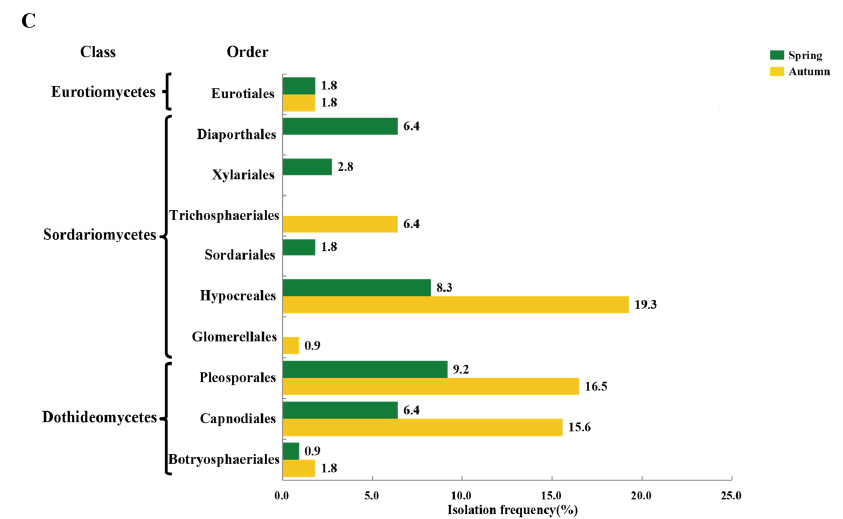
Figure 4. Comparison of the relative abundance of the most abundant taxa of endophytic fungi of mulberry in two seasons. ( A ) The 10 most abundant fungal classes in spring and autumn samples based on ITS amplicon sequencing. ( B ) The 10 most abundant fungal orders in spring and autumn samples based on ITS amplicon sequencing. ( C ) Taxonomic distribution (class-level and order-level) of isolates in spring and autumn samples based on the culture-dependent method. Different colors represent different groups. The dot indicates the percentage difference in abundance between the two groups, the color of the dot is presented as the group color with a large abundance. *** p < 0.001, ** p < 0.01, * p < 0.05. Welch’s t -test and p -value were corrected by the FDR method. The isolation frequency (IF) was calculated using the formula: IF (%) = the number of isolates of a certain taxa/the total number of isolates ×